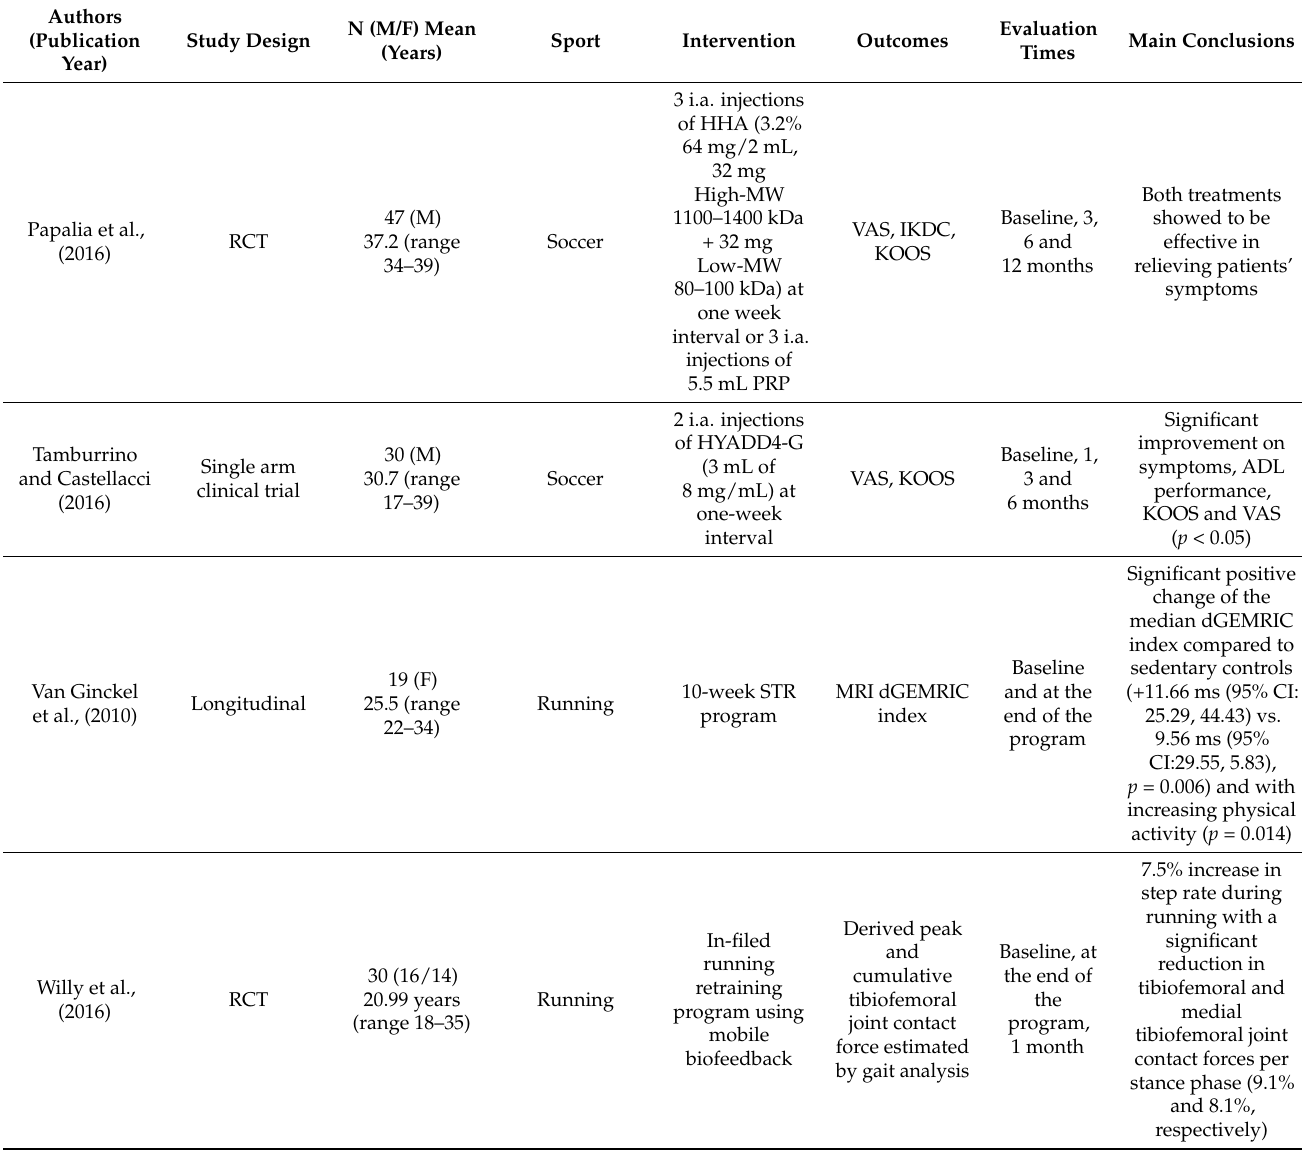
Table 1. Characteristics of the included studies. RCT, randomized controlled trial. i.a.,